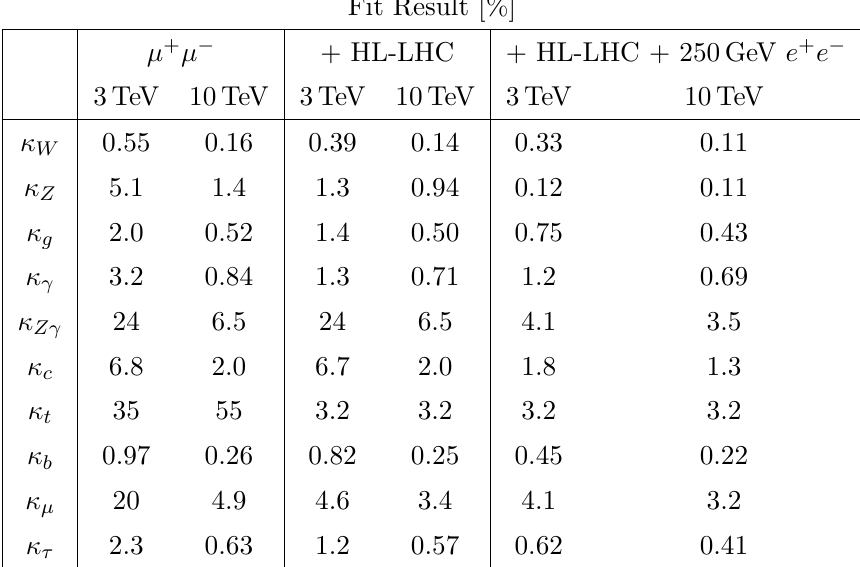
Table 11 . Results of a 10-parameter fit to the Higgs couplings in the κ -framework, based on the attainable precision in each production and decay channel without forward muon tagging listed in table 9.